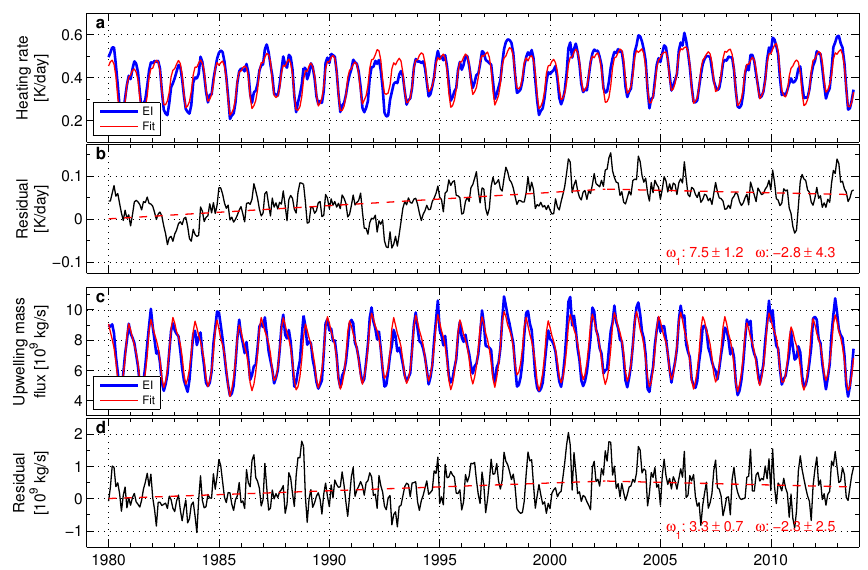
Figure 4. Regression analysis of EI LS all-sky heating rate (17–21km; a, b ) and upwelling mass flux (70hPa; c, d ). Setup identical to Fig. 3 otherwise.